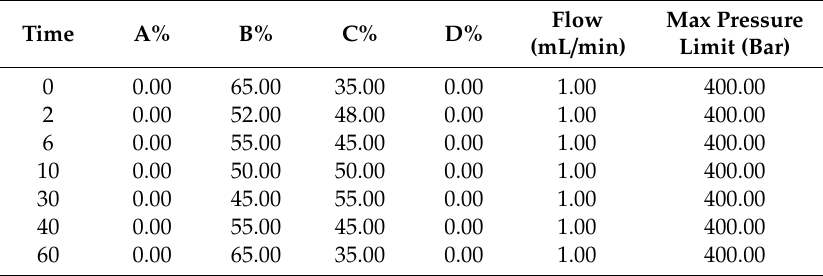
Table 1. HPLC gradient